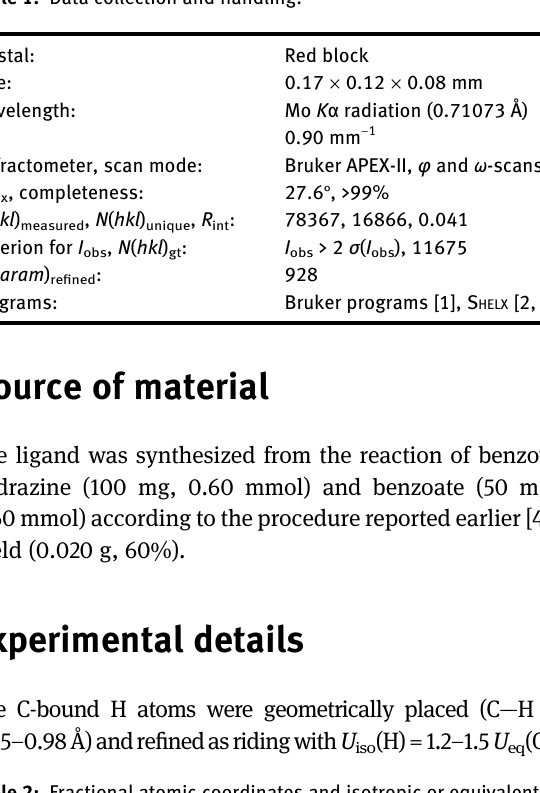
Table  : Fractional atomic coordinates and isotropic or equivalent isotropic displacement parameters (Å  ).